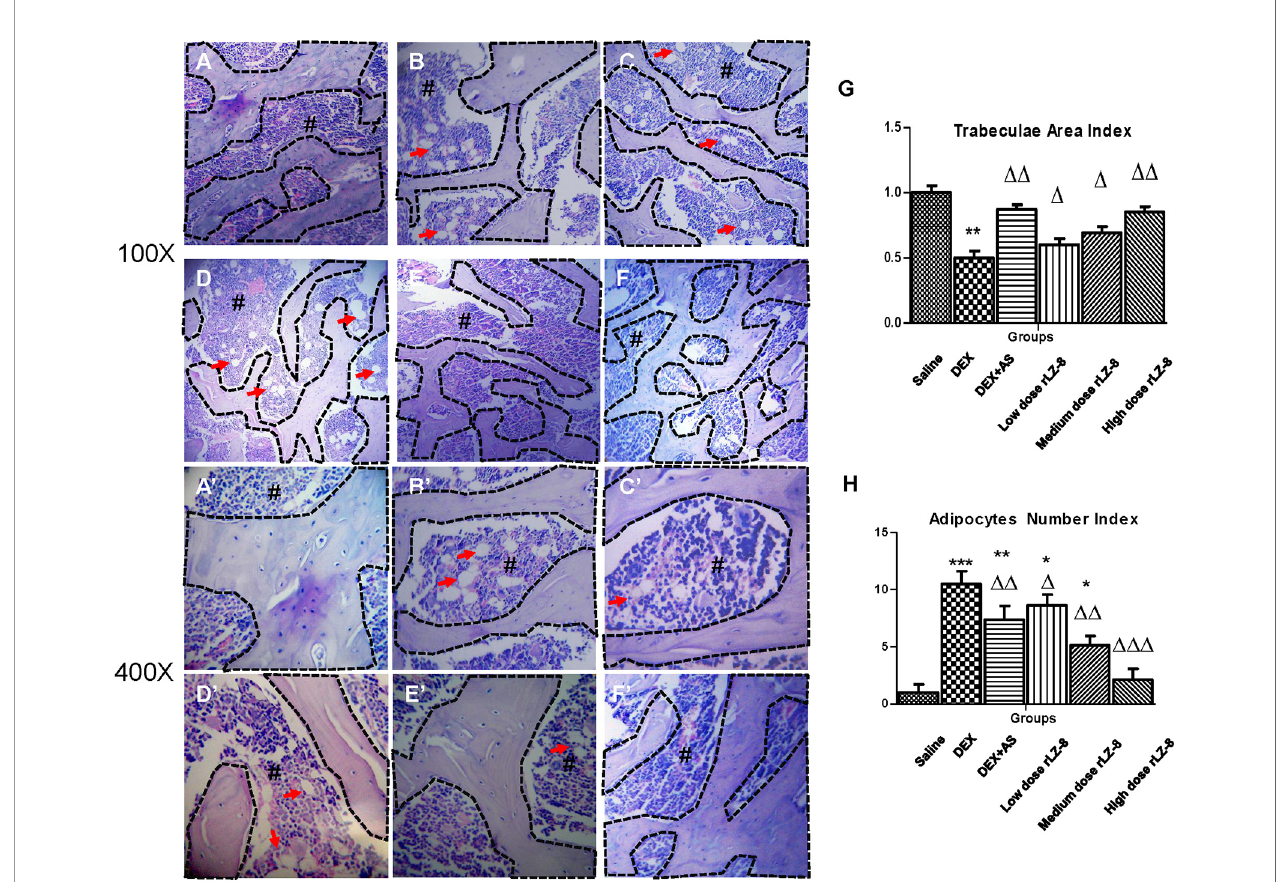
FIGURE 3 | Protective effect of rLZ-8 on bone histomorphometry change caused by DEX. Groups (A – F) are the representative HE staining graphs taken at 100-fold magni fi cation of blank control group (A) , GIOP model group (B) , positive control group ( C , DEX + AS), rLZ-8 low dose group (D) , DEX + 28.0 m g/kg BW rLZ-8), rLZ- 8 medium dose group ( E , DEX + 56.0 m g/kg BW rLZ-8) and rLZ-8 high dose group (F) , DEX + 112.0 m g/kg BW rLZ-8). Graphs (A – F) are taken at 400-fold magni fi cation. The area marked # with deeper staining is the bone marrow region. Cells labeled by arrows are bone marrow adipocytes. The area bounded by a dotted line represents the bone trabeculae region. (G) : trabeculae area index (trabeculae area in each group/area in the saline group) of the six groups. (H) : Adipocytes number index (adopocytes number in fi xed area of each group/adopocytes number in fi xed area of saline group) of the six groups. Each groups use fi ve independent slices (* P < 0.05, ** P < 0.01 and *** P < 0.005 versus saline group; △ P < 0.05, △△ P < 0.01, and △△△ P < 0.005 versus DEX